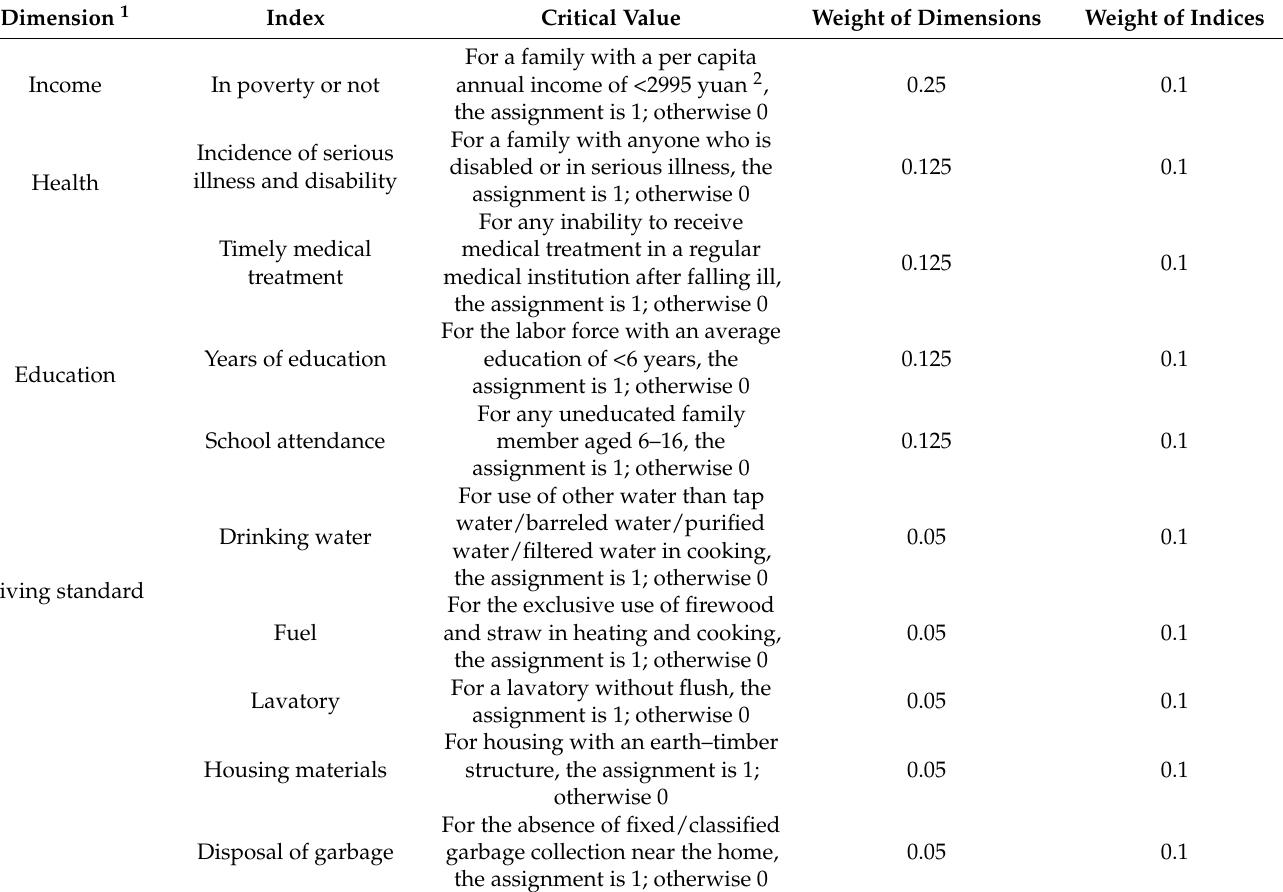
Table 1. System of measuring the multidimensional poverty of